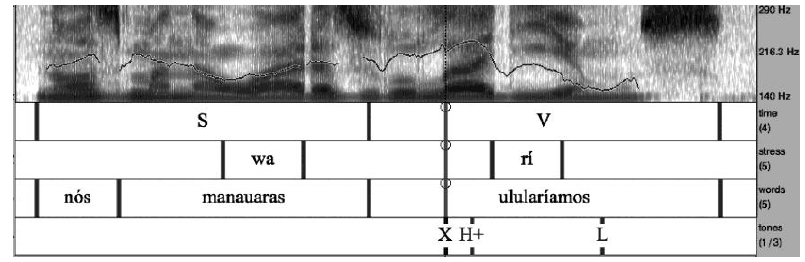
Figure 7. F0-track from recording with narrow focus on the